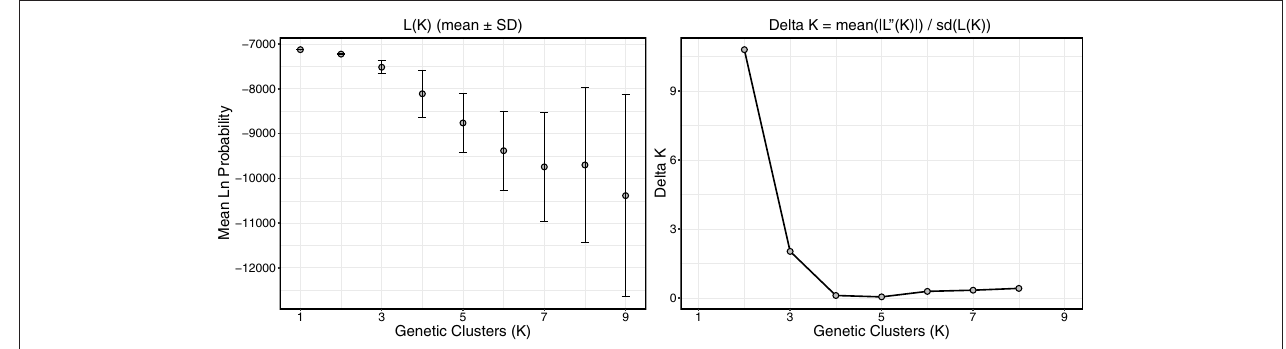
FIGURE 4 | Plots describing the process behind population cluster (K) selection in structure analysis. Ten replicate structure models were run across a range of K values from 1 to 9 and model log likelihoods were compared. The Evanno method was used to determine the most likely number of K by identifying the largest change in likelihood (L(K)) and by comparing model probabilities in conjunction with variance (Delta K). Error bars represent standard deviation of the mean.